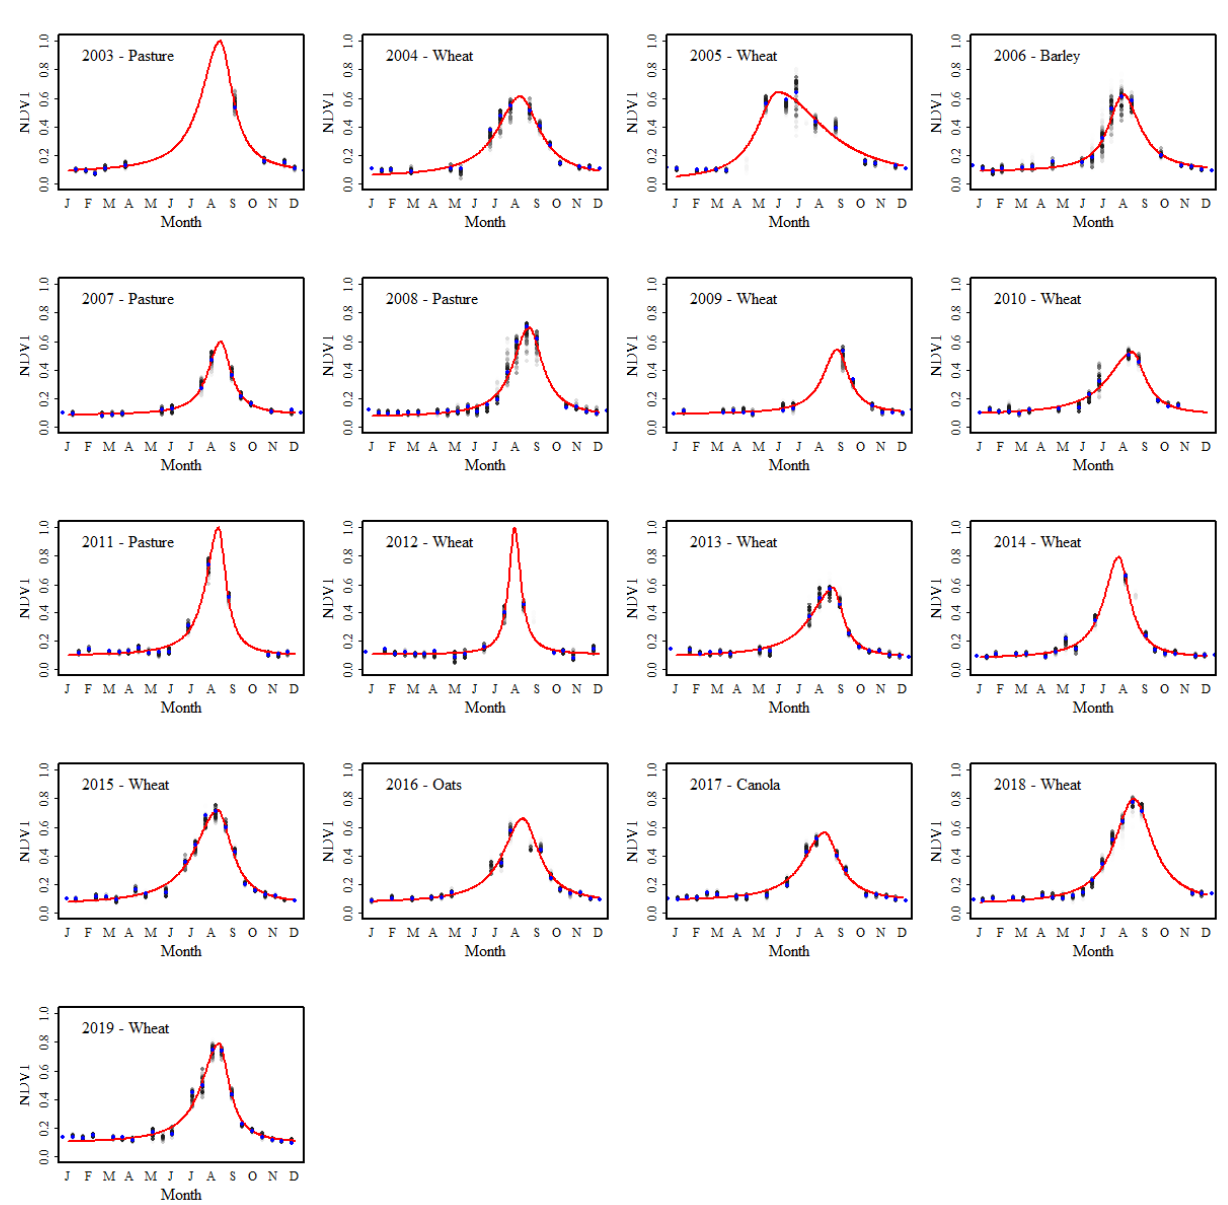
Figure 3. Example of spatially weighted growth curve estimation for a typical cell. The estimated growth curve is shown in red, NDVI data used in the estimation are shown in shades of grey according to their spatial weight (white lowest and black highest) and NDVI data for the cell are shown in blue.